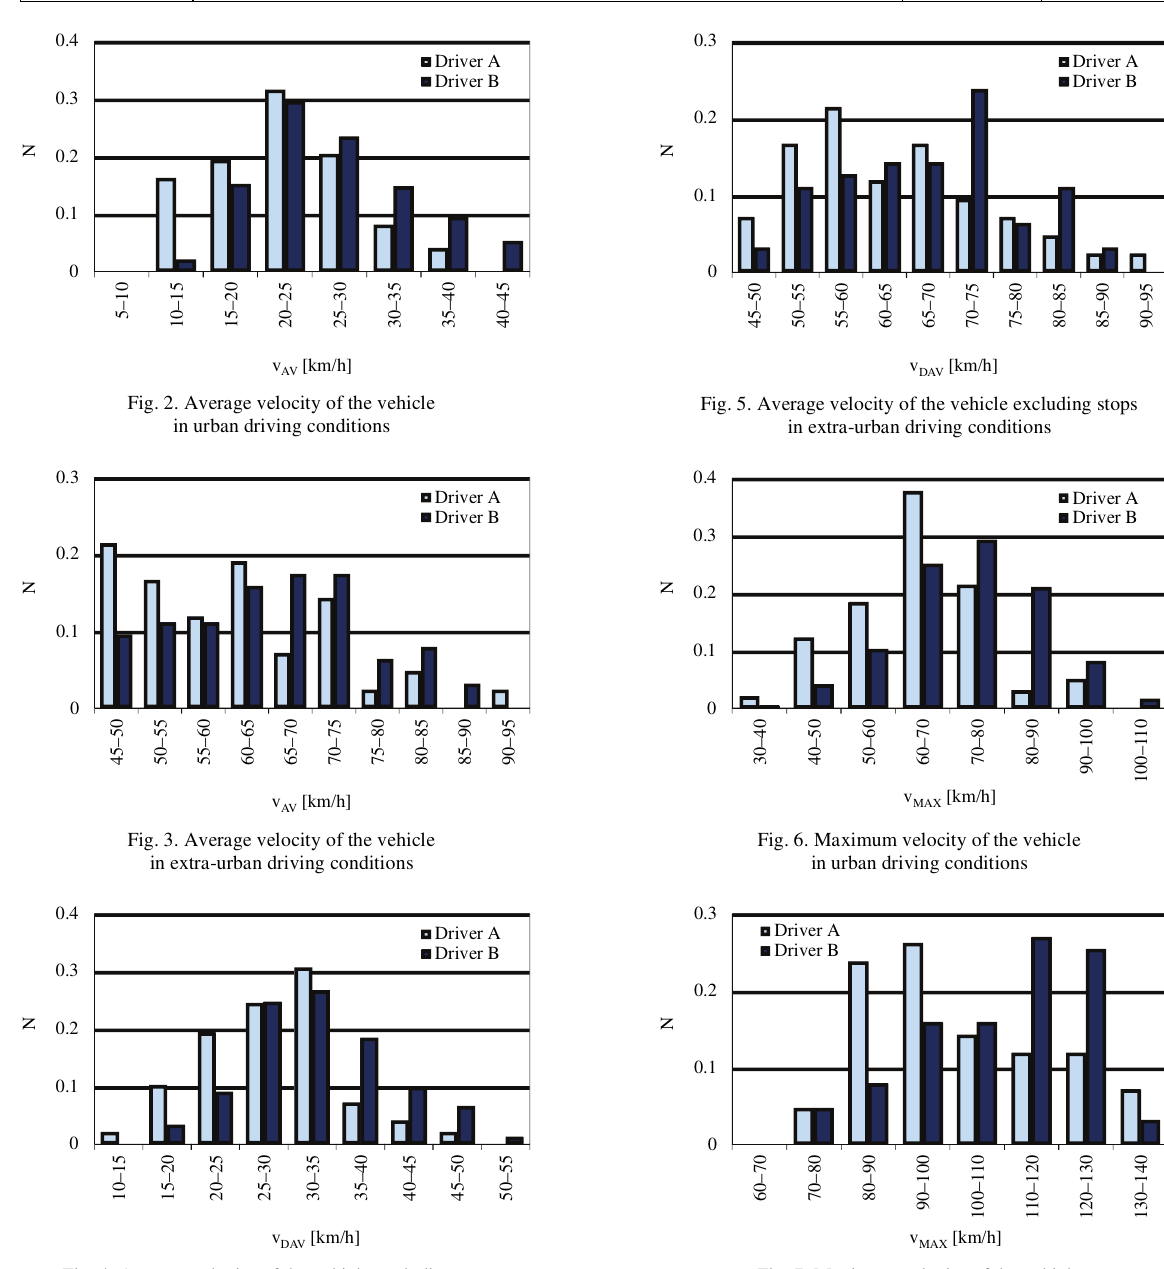
Fig. 7. Maximum velocity of the vehicle in extra-urban driving